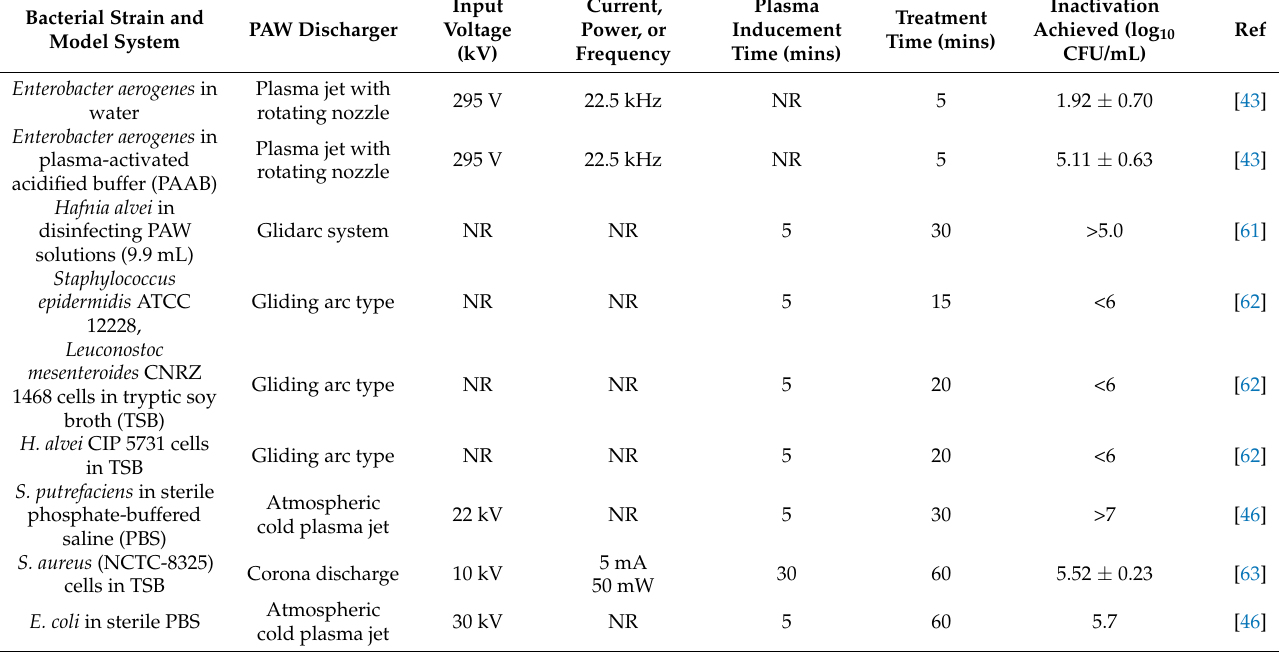
Table 3. The effect of PAW on microbial inactivation in non-food